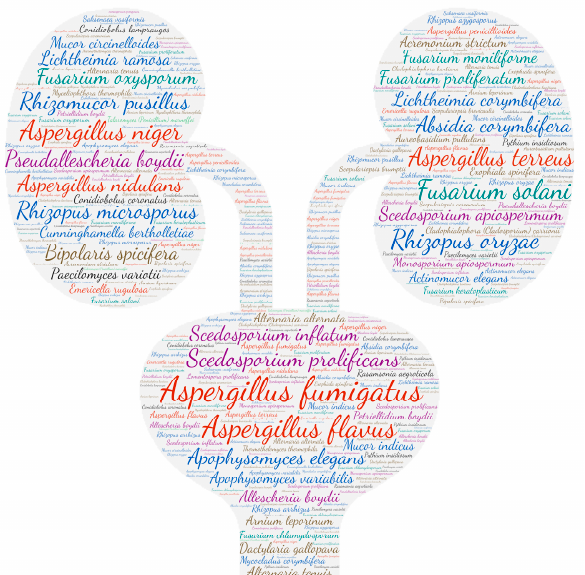
Figure 11. Wordcloud represents the species name isolated in the urinary tract. The size of the name of each species is proportional to the number of times it occurs in the repertoire.